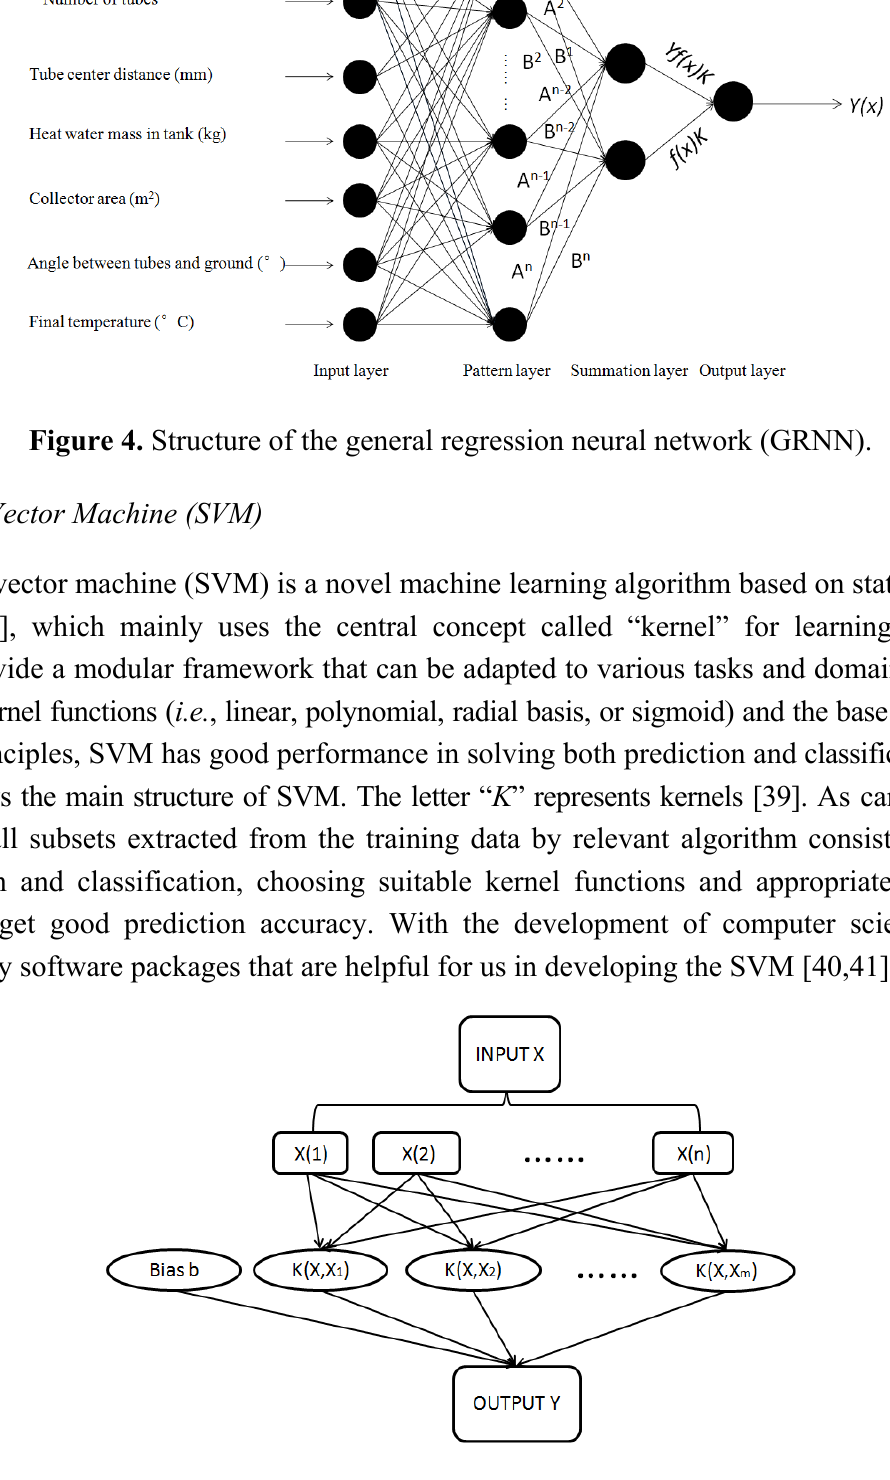
Figure 5. Main structure of the support vector